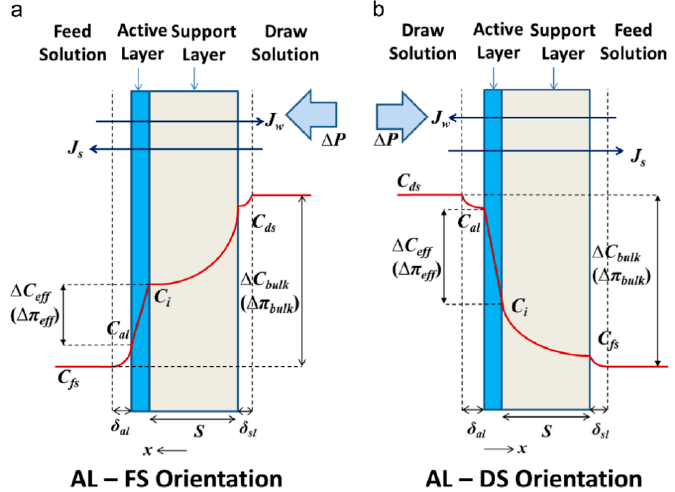
Figure 2. Schematic Diagram of Concentration Polarization in AL-FS and AL-DS Modes.